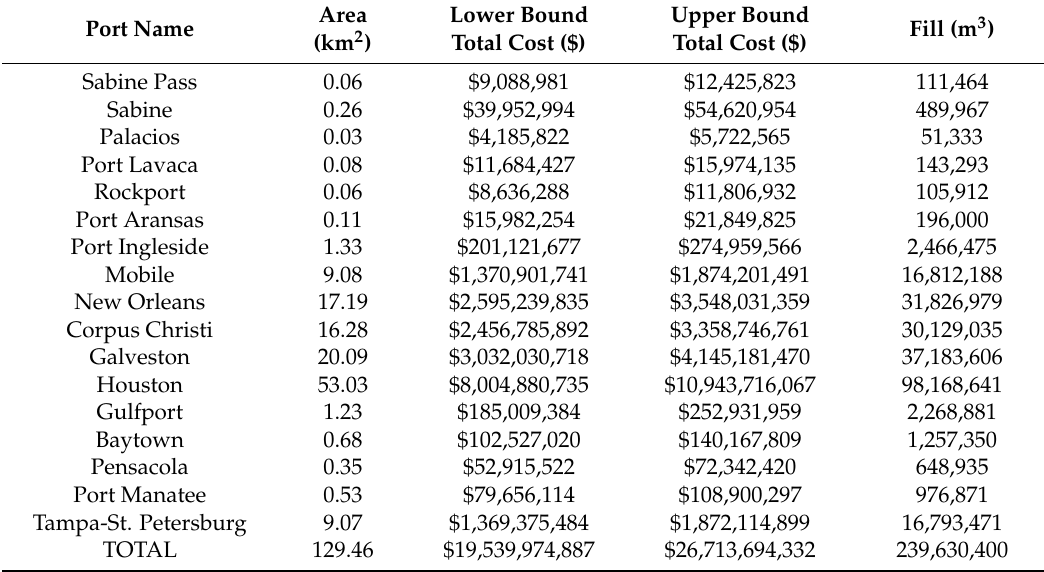
Table A2. Cost and materials required to elevate and retrofit Gulf Coast Seaports in response to two meters of sea level rise.